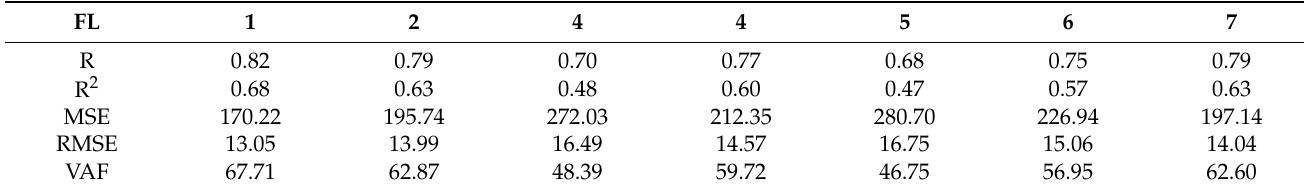
Table 13. Statistical indices of the FL models obtained for each model.